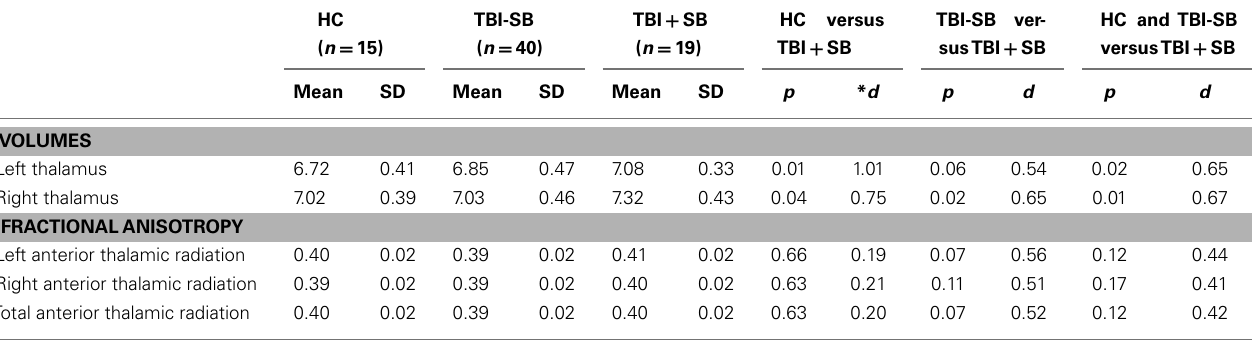
Table 2 | Between-group differences comparing anterior thalamic radiations fractional anisotropy and thalamic volumes (cm 3 ) adjusted for brain segmented